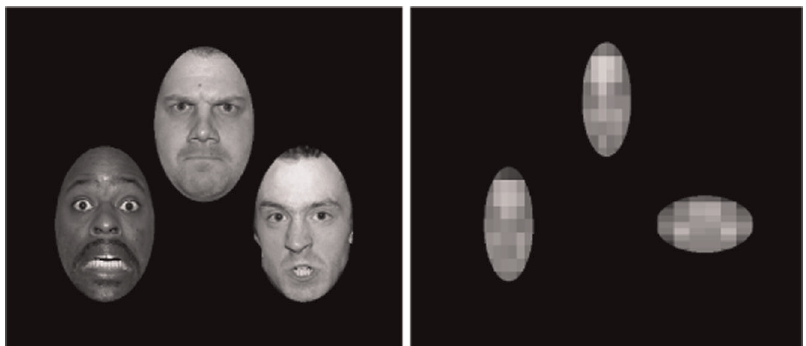
Figure 1. Screenshots of the emotion and shape matching task stimuli. Each screen remained visible for 5 seconds during which time subjects responded by pressing the button in their left or right hand to record which lower image (left or right) matches the upper image.